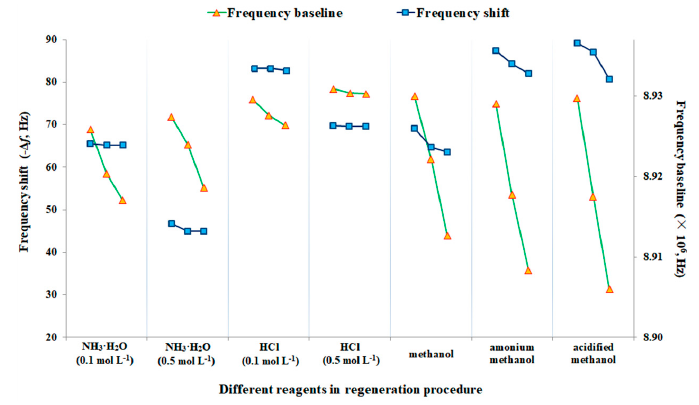
Figure 6. Comparison of the results in the regeneration procedure using different regeneration solutions.